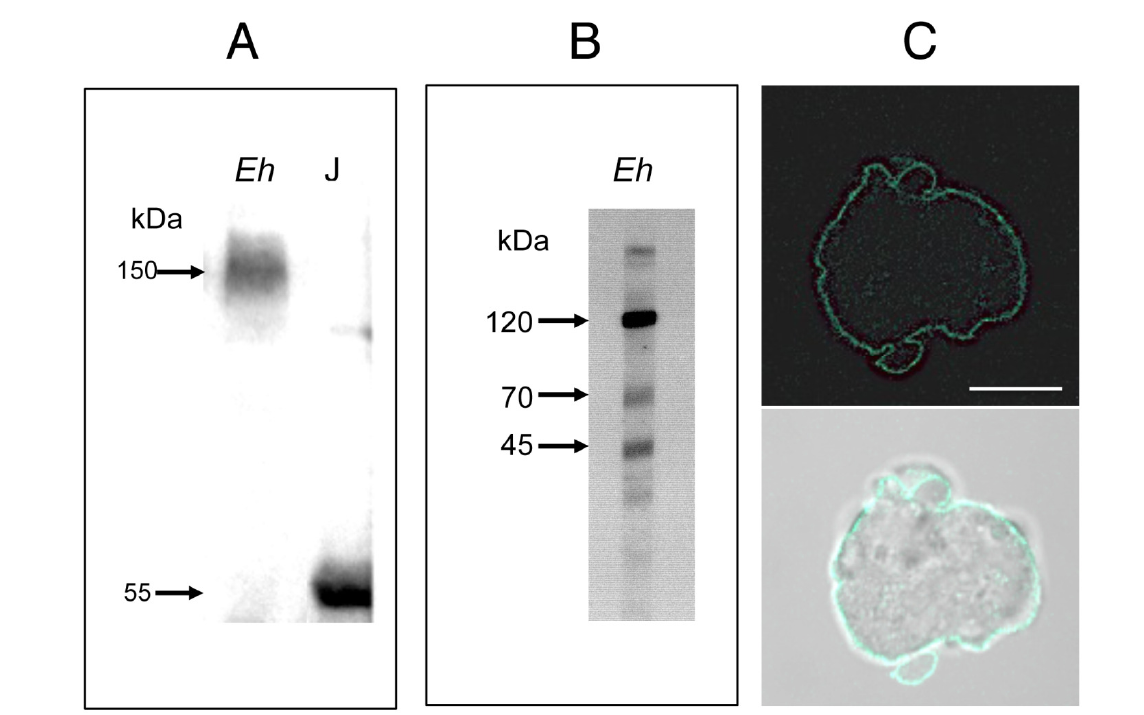
FIGURE 1: Screening of an E. histolytica protein extract with an antibody against human soluble hTNFR1. (A) Polyacrylamide gel electro- phoresis under non-reducing conditions, and a Western blot analysis. Crude lysates of E. histolytica (Eh) and Jurkat (J) cells were loaded in the indicated lane (load: 20 µg of protein). Probing with the anti-hTNFR1 antibody revealed a single 150 kDa protein in E. histolytica and a single 55 kDa protein in Jurkat cells. (B) Polyacrylamide gel electrophoresis under reducing conditions, and a Western blot analysis. In a crude lysate from E. histolytica ¸ three proteins (at approximately 120 kDa, 70 kDa and 45 kDa) were detected. (C) Entire trophozoites were fixed and stained with goat anti-hTNFR1 and anti-goat AlexaFluor488 in order to reveal the localization of amoebic proteins sharing an epitope with hTNFR1. Scale bar: 10